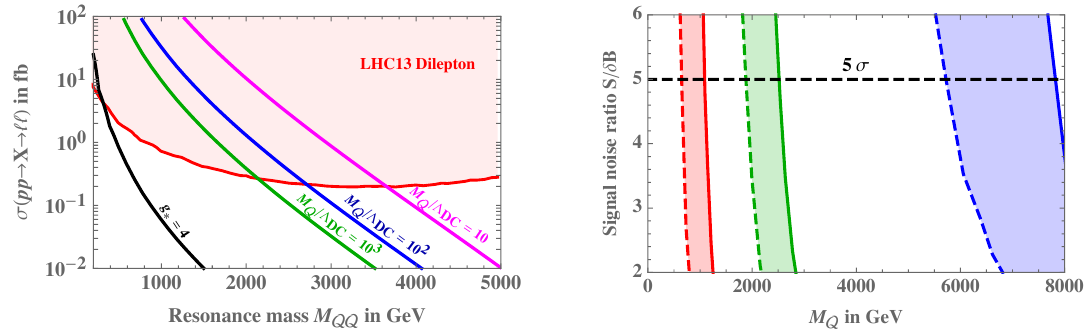
Figure 5 . Left: ATLAS bounds on the cross section for the direct production of a spin-1 QQ reso- nance decaying into muons and electrons [48]. Right: estimated reach on gluequark pair production obtained by recasting the limits of ref. [49] from disappearing tracks searches at the HL-LHC (red), the HE-LHC (green) and a 100 TeV collider (blue). The solid (dashed) lines assume a 20% (500%) uncertainty on the background